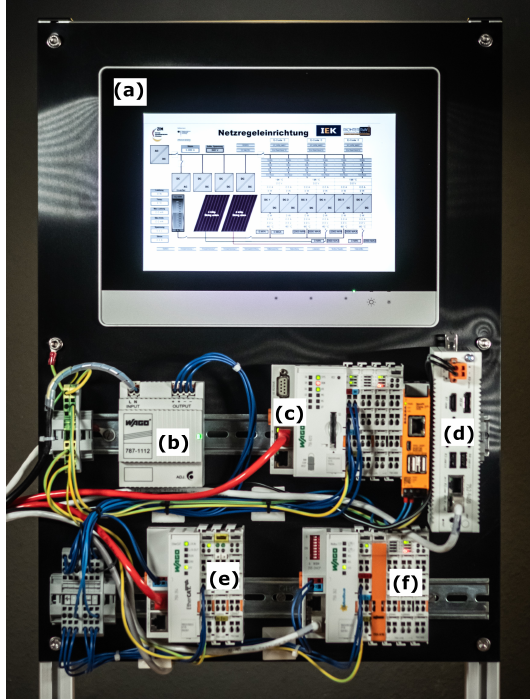
Figure 2. Hardware setup: ( a ) Human–machine interface, ( b ) power supply, ( c ) PLC, ( d ) edge computer, ( e , f ) fieldbus-coupled input and output modules of the